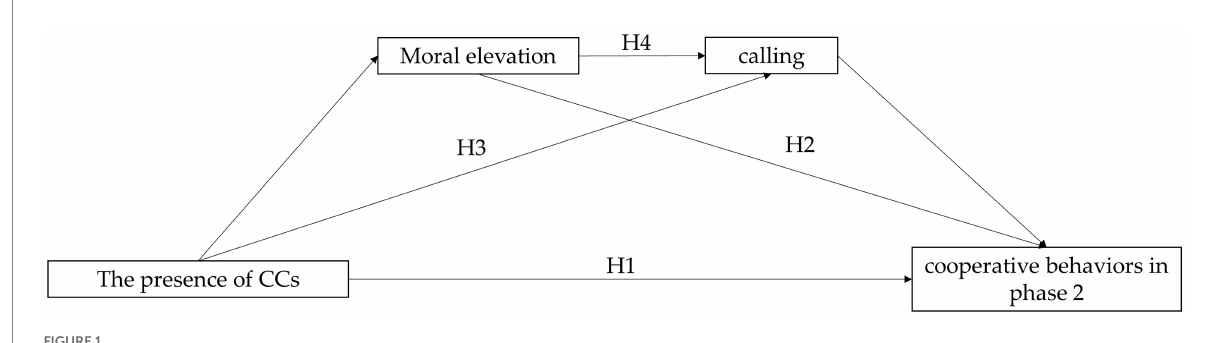
FIGURE 1 The hypothesized framework of this